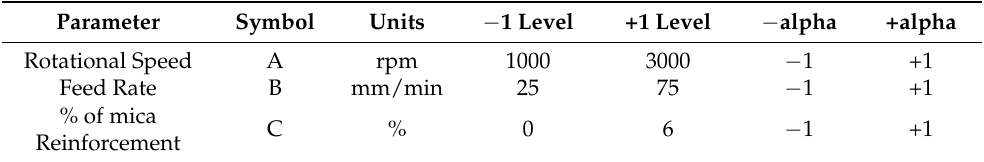
Table 2. Input process variables.